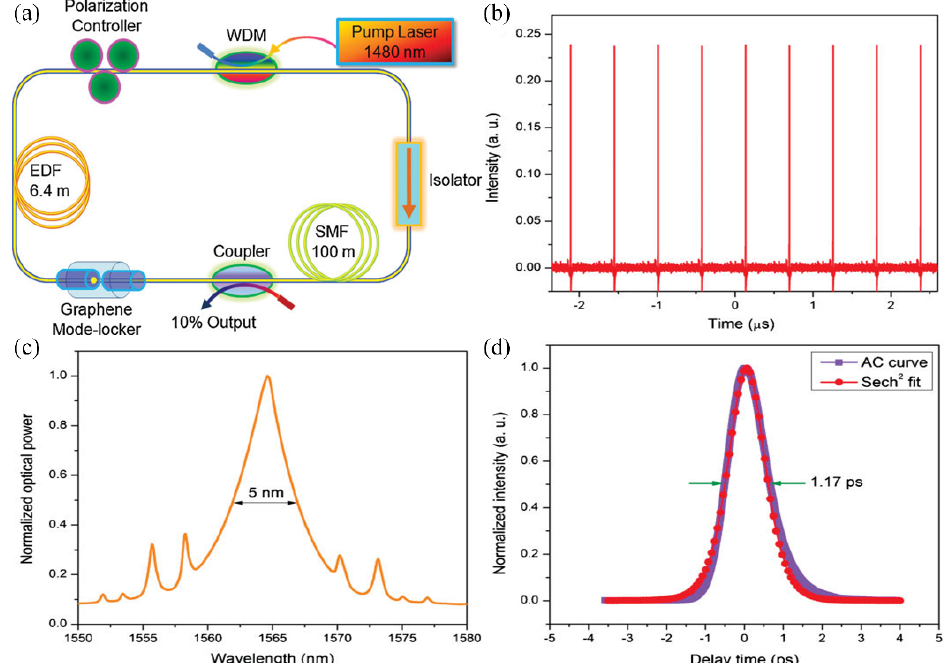
Figure 7. CVD-grown graphene mode-locked EDFL. ( a ) Laser configuration; ( b ) output pulse train; ( c ) output laser spectrum; ( d ) autocorrelation trace [112]. Reproduced with permission, Copyright 2009, Wiley-VCH.